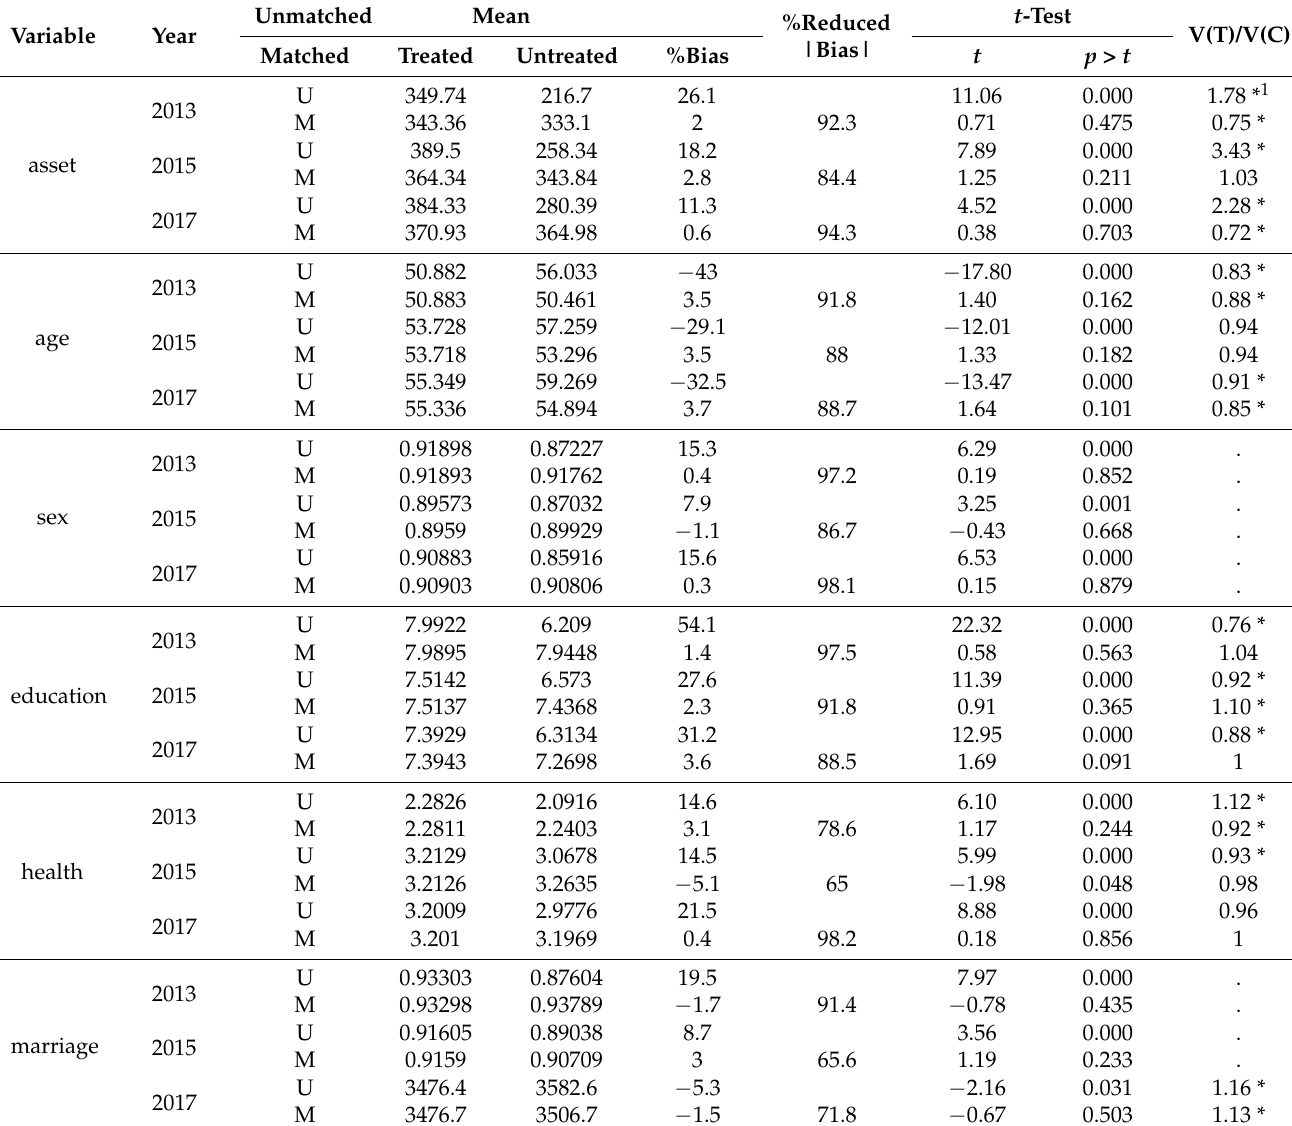
Table 7. PSM method balance